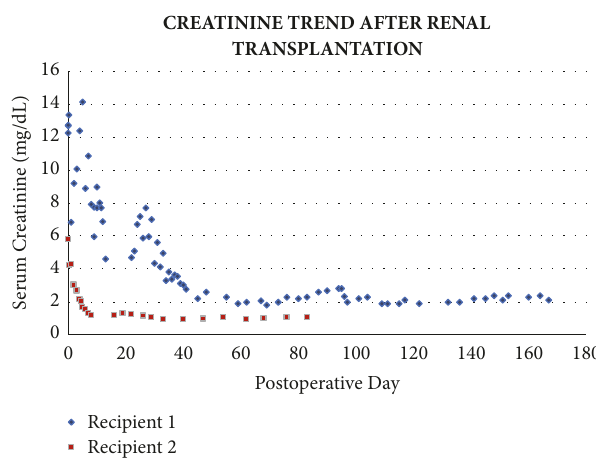
Figure 2: Serum creatinine (mg/dL) following renal transplan- tation. Above demonstrates the significant improvement in renal function after renal transplantation and the sustained viability of each